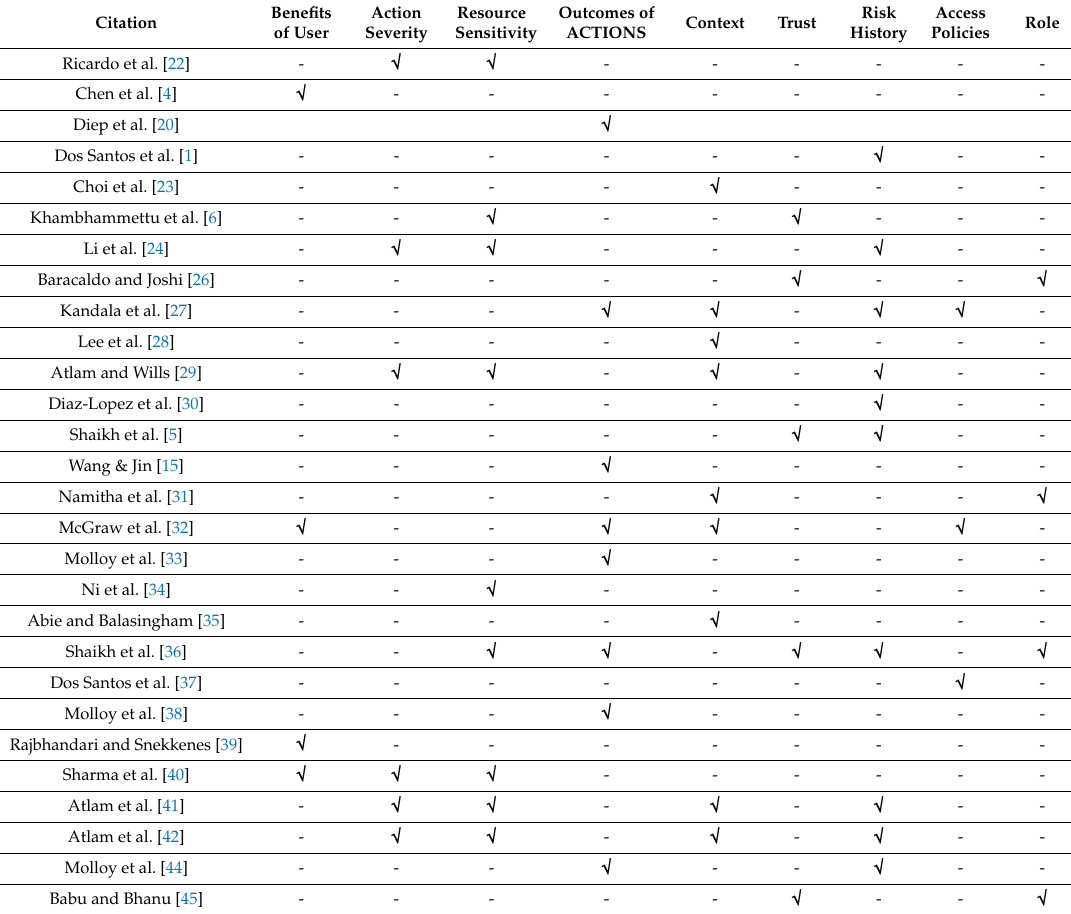
Table 5. Risk factors used in retrieved / analyzed publications of risk-based access control